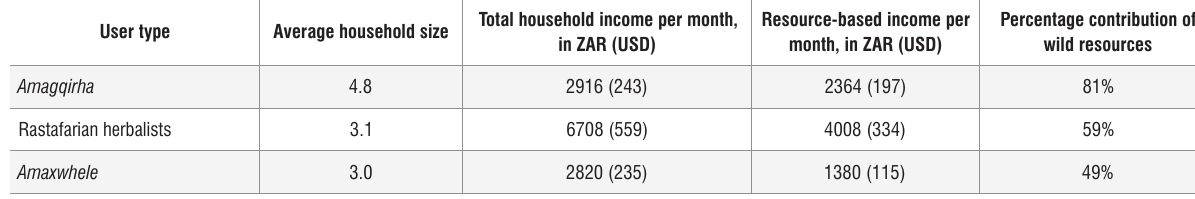
Economic contribution of wild harvested resources to traditional healer